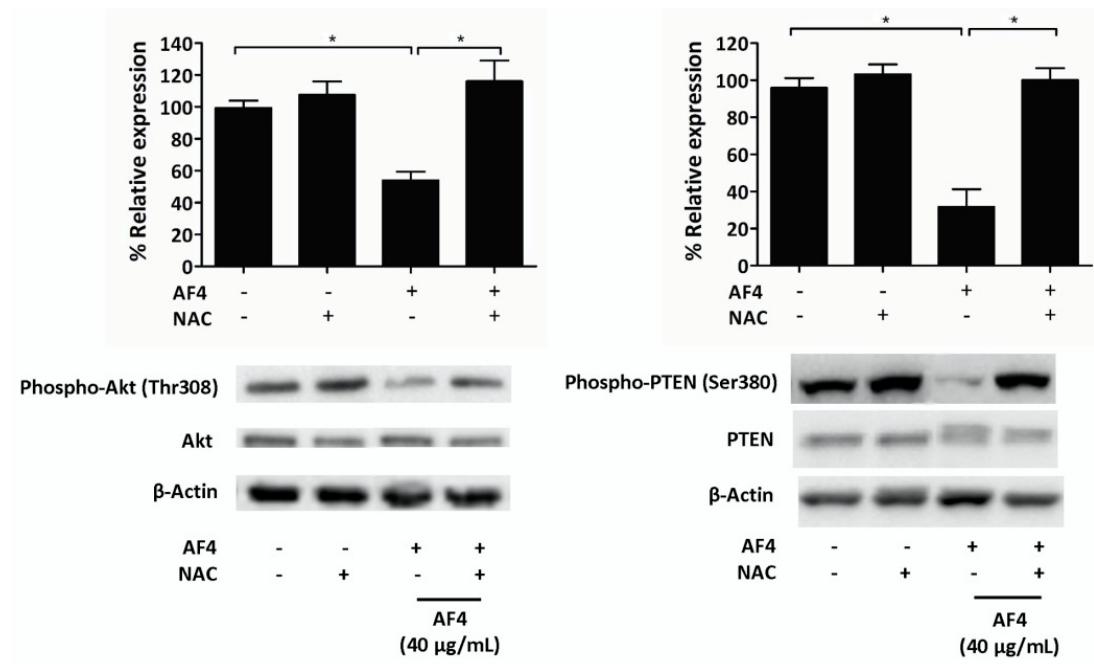
Figure 5. AF4 inhibits Akt and phosphatase and tensin homolog (PTEN) phosphorylation in breast cancer cells. MDA-MB-231 cells were cultured for 24 h in the absence or presence of 40 µ g / mL AF4 without or with 5 mM NAC. Relative expression of phospho-Akt (Thr308), total Akt, phospho-PTEN (Ser380), and total PTEN was determined using Western blot analysis. Equal protein loading was confirmed by probing for β -actin expression. Data are shown as representative blots and mean % relative expression ± SEM of 3 independent experiments. Statistical analysis was performed using ANOVA and Tukey’s multiple comparisons test; * p < 0.05.